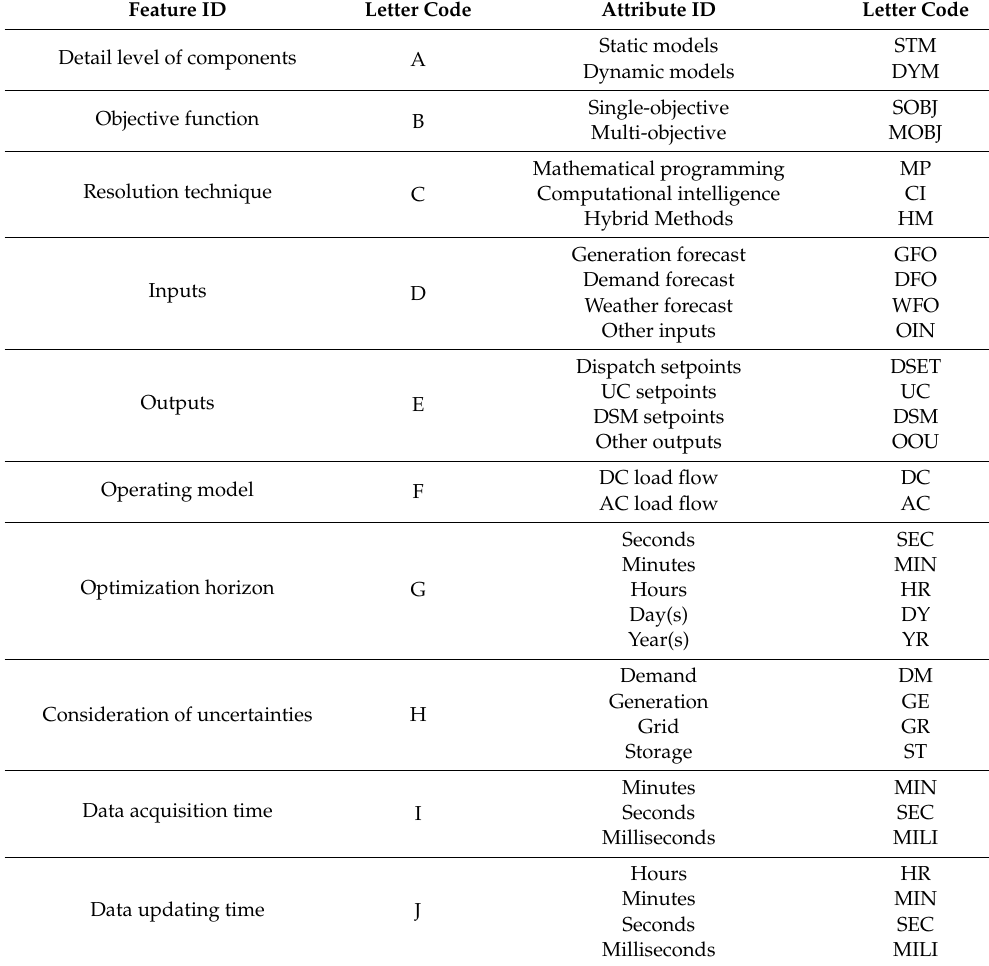
Table 1. Letter code for features and